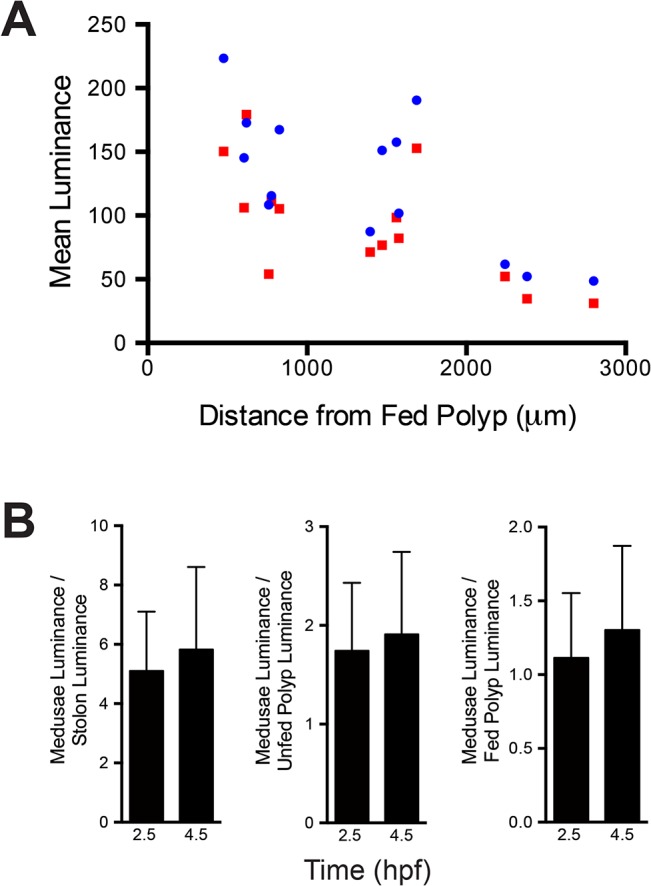
Medusae luminance.(A) Mean luminance of medusae as a function of their distance from the fed polyp at 2.5 (blue) and 4.5 (red) hpf. (B) Mean luminance of medusae standardized to mean luminance of adjacent stolons, unfed polyps, and fed polyps at 2.5 and 4.5 hpf. Errors bars show one standard deviation.